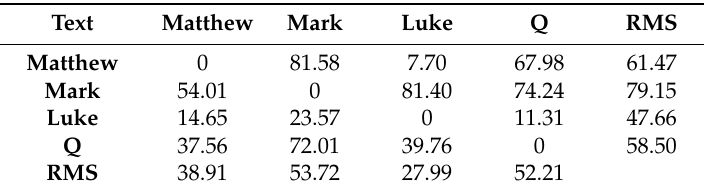
Table 11. Triple Tradition and Q. Kolmogorov–Smirnov test results for I P (below the diagonal of zeros) and M F (above the diagonal). The values reported are the confidence level (%) that the indicated couple of probability distributions are not identical.